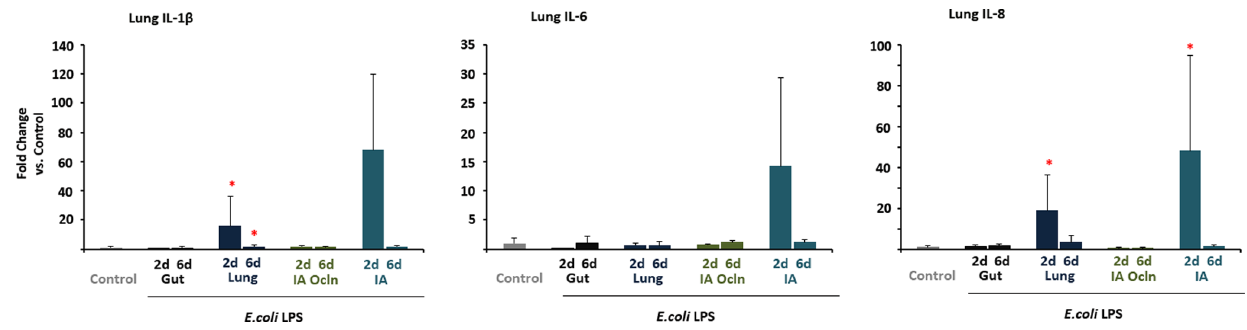
Figure 1. LPS infusion in the lung or the amniotic fluid induced lung cytokine expression. Quantification of messenger RNAs for IL-1 b (A), IL-6 (B) and IL-8 (C) was performed by real-time PCR assays using sheep-specific primers and hydrolysis probes. Each cytokine was normalized to 18s ribosomal protein mRNA (internal control), and levels for each group were expressed relative to controls as fold increase relative to controls. Cytokine expression increased in the 2d ‘‘Lung’’ and the 2d ‘‘IA’’ LPS groups (* p , 0.0125 vs. control for IL-1 b and IL-8, p , 0.05 for IL-6 vs. control).